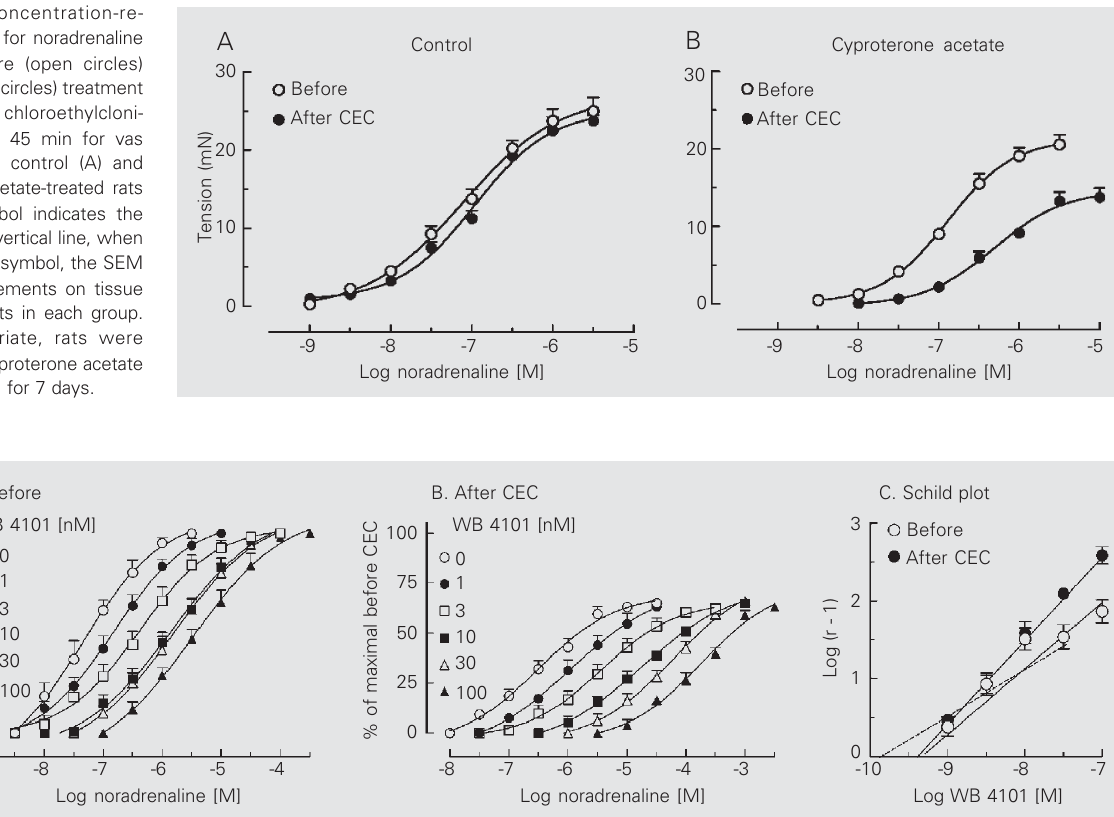
Figure 5. A , Concentration-response curves for noradrenaline (before treatment with 100 µM chloroethylclonidine for 45 min) obtained for vas deferens from rats treated with cyproterone acetate (10 mg/day, sc, for 14 days) in the absence (open circles) and presence of WB 4101 at concentrations of 1.0 (filled circles), 3.0 (open squares), 10 (filled squares), 30 (open triangles) and 100 nM (filled triangles). B , Concentration-response curves for noradrenaline (after treatment with 100 µM chloroethylclonidine for 45 min) obtained for vas deferens from cyproterone acetate-treated rats (10 mg/day, sc , for 14 days) in the absence (open circles) and presence of WB 4101 at concentrations of 1.0 (filled circles), 3.0 (open squares), 10 (filled squares), 30 (open triangles) and 100 nM (filled triangles). C, Schild plot obtained for WB 4101. Each symbol represents the mean and the vertical line, when larger than the symbol, the SEM of 5 determinations on tissue from 5 rats. CEC = chloroethylclonidine.